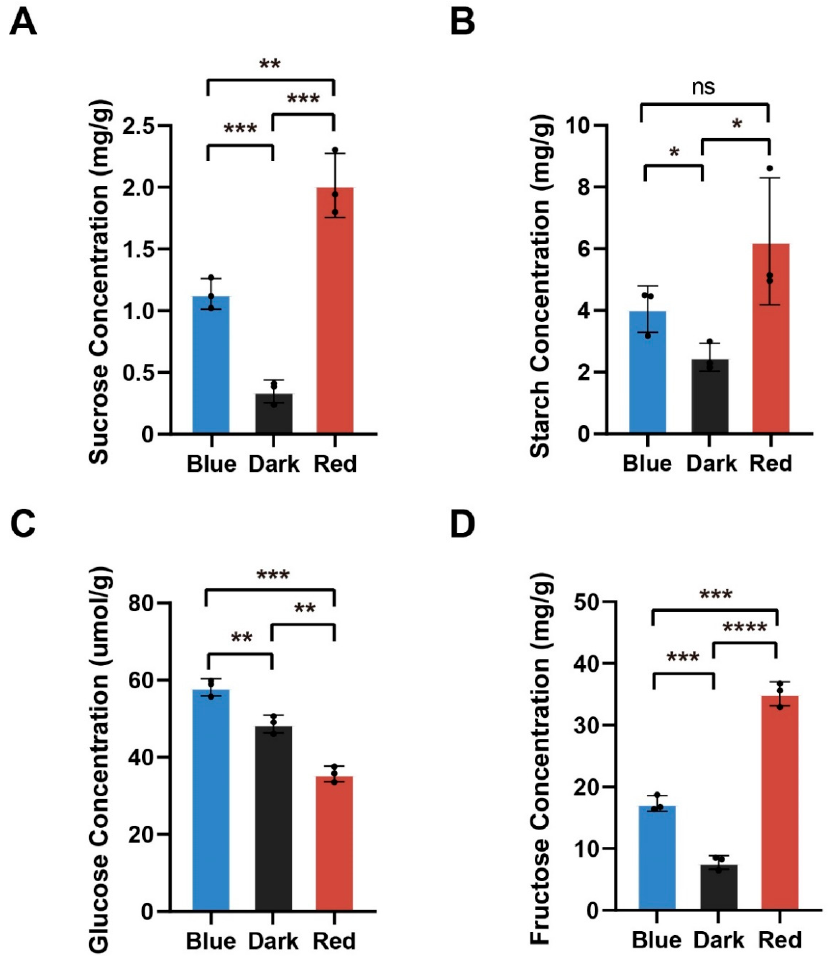
Figure 8. Comparison of soluble sugar and starch contents in moso bamboo seedlings under different light treatments. ( A – D ) Differences in sucrose ( A ), starch ( B ), fructose ( C ), and glucose ( D ) in moso bamboo under different light treatments. Data are presented as mean ± SD ( n = 3 biological replicates). Significant differences were analyzed by two-tailed Student’s t -test ( ns p > 0.05, * p < 0.05, ** p < 0.01, *** p < 0.001, **** p < 0.0001).